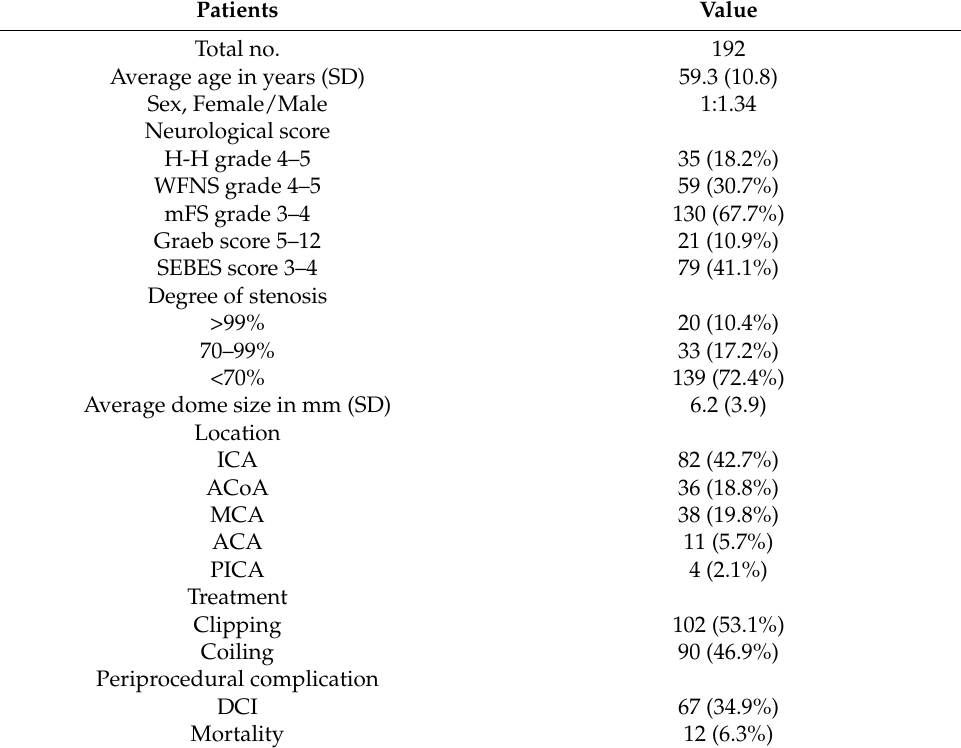
Table 1. Baseline characteristics of patients with coexistent aSAH and ICAS.